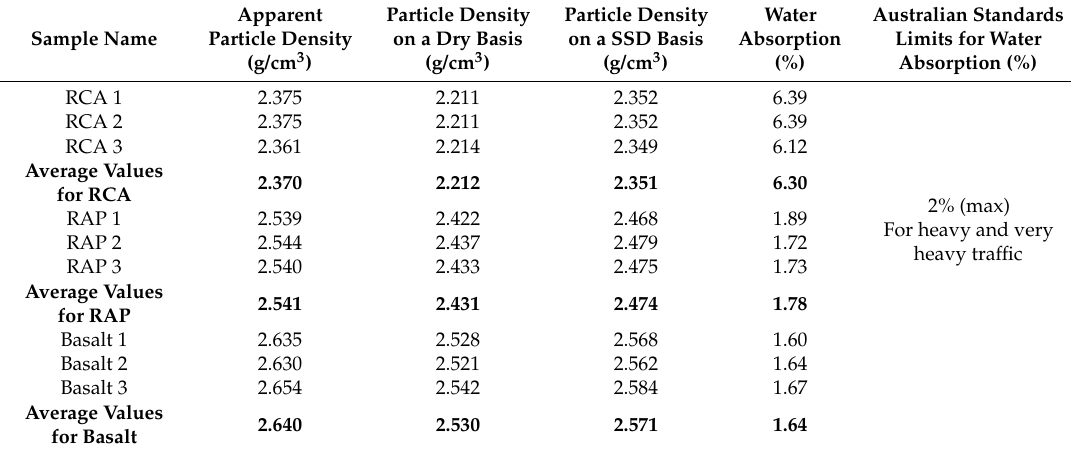
Table 4. The Results of Particle Density and Water Absorption Test on Coarse Aggregates and Water Absorption Limits for Dense Graded Asphalt Based on Australian Standards.